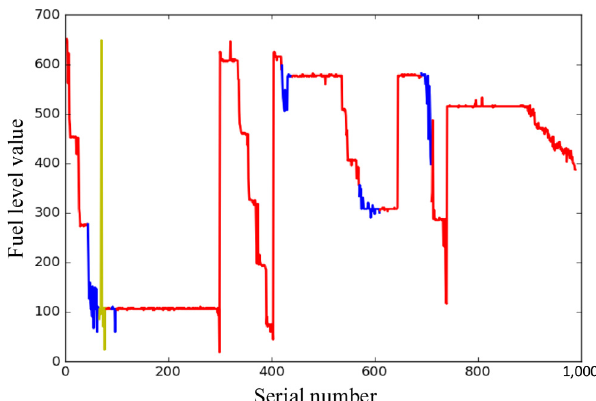
Figure 3 Processed fuel level data